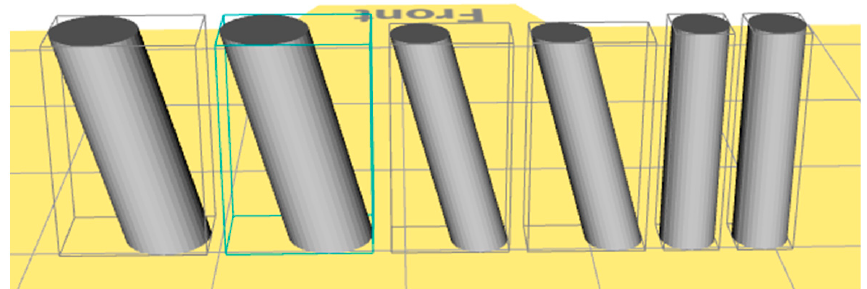
Figure 2. Example for the automatically generated arrangement of three different cylinder geometries using the bounding box